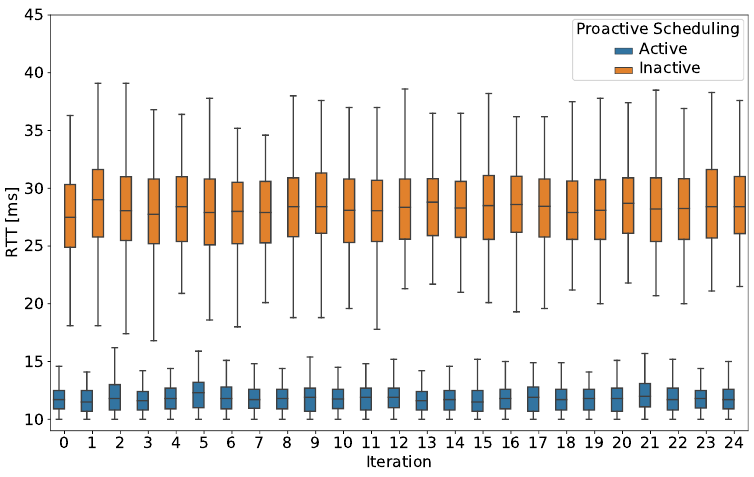
Figure 5. Experiment 2: RTT per-iteration statistics for TC_RTT test case, in SC_LoS_PS (PS active) and SC_LoS (PS inactive) scenarios and using